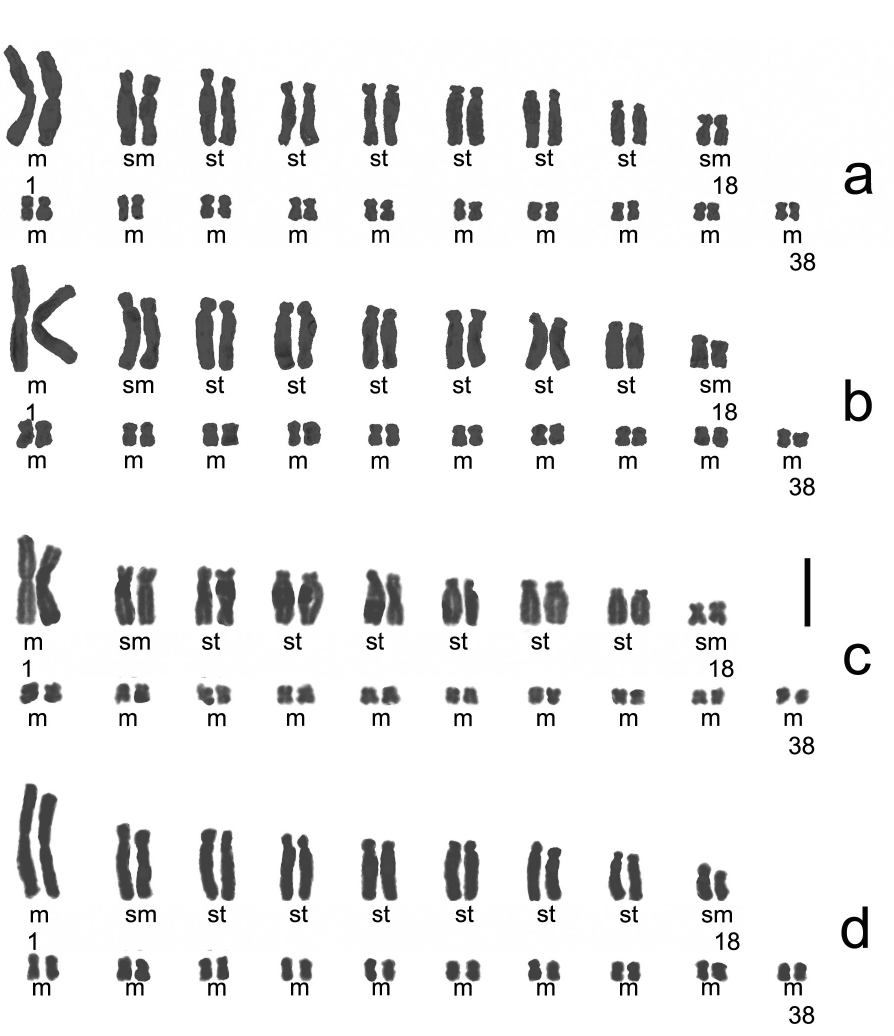
Figure 4. Karyotype of Aspidistra subrotata of 2n = 38, formulated as 2n = 22 m + 4 sm + 12 st. a Mt. Poman population b, c Mt. Daqing population d Mt. Bavi population. Bar = 10